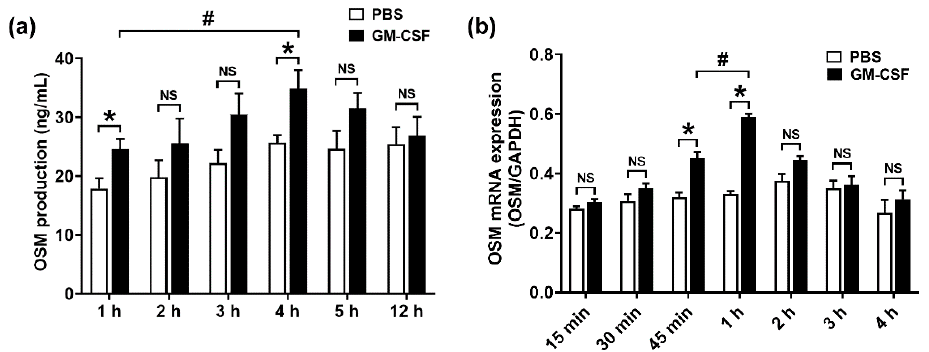
Figure 1. Production and mRNA expression of OSM in neutrophil-like dHL-60 cells. ( a )